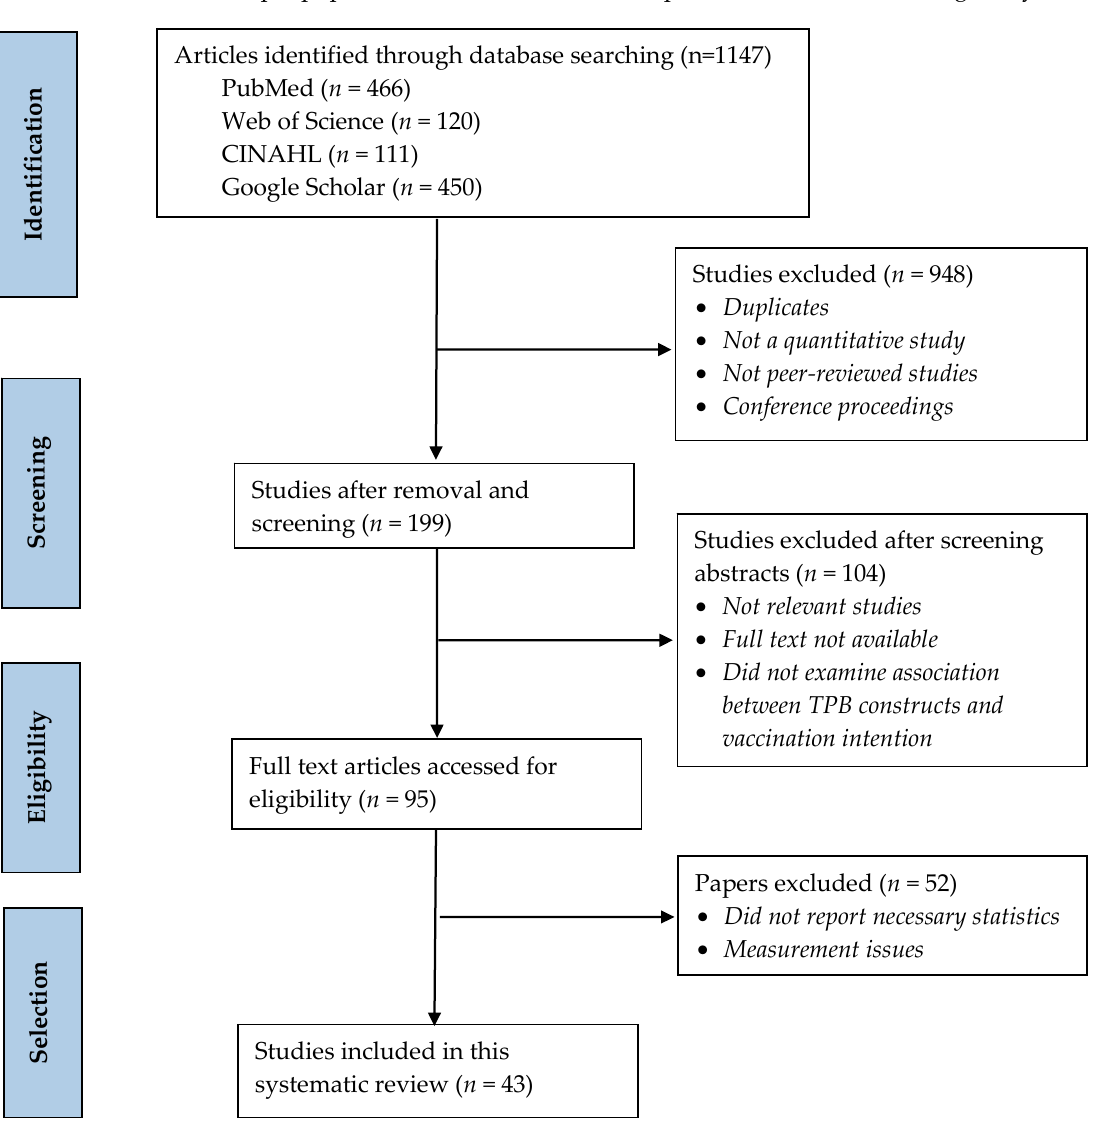
Figure 1. PRISMA flow diagram showing search strategy and study selection process.